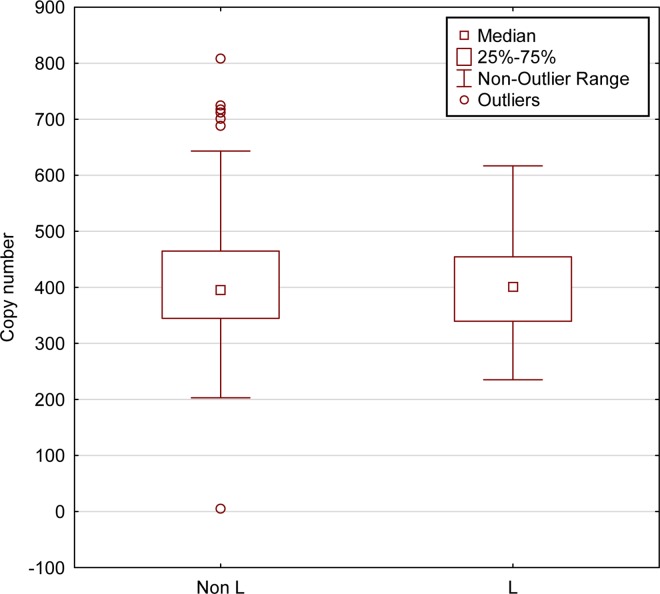
mtDNA copy numbers do not differ between L-haplogroup and non-L-haplogroup individuals.mtDNA copy numbers were calculated for individuals for which DNA-seq was available (N = 436, 1000 Genomes Project). No differences were detected in mtDNA copy numbers between L-haplogroup and non-L-haplogroups (Kruskal-Wallis test, KW-H (1436) = 0.262, p = 0.6088). X-axis–L-haplogroup versus non-L-haplogroup individuals, Y-axis–calculated mtDNA copy numbers.